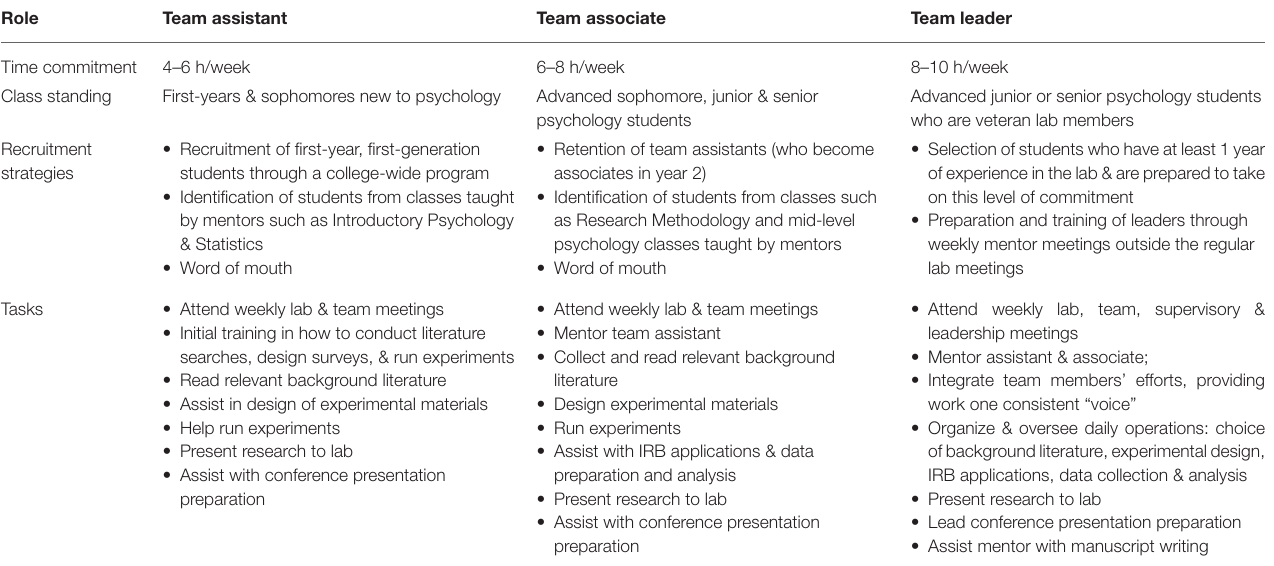
TABLE 1 | Team structure, recruitment, and